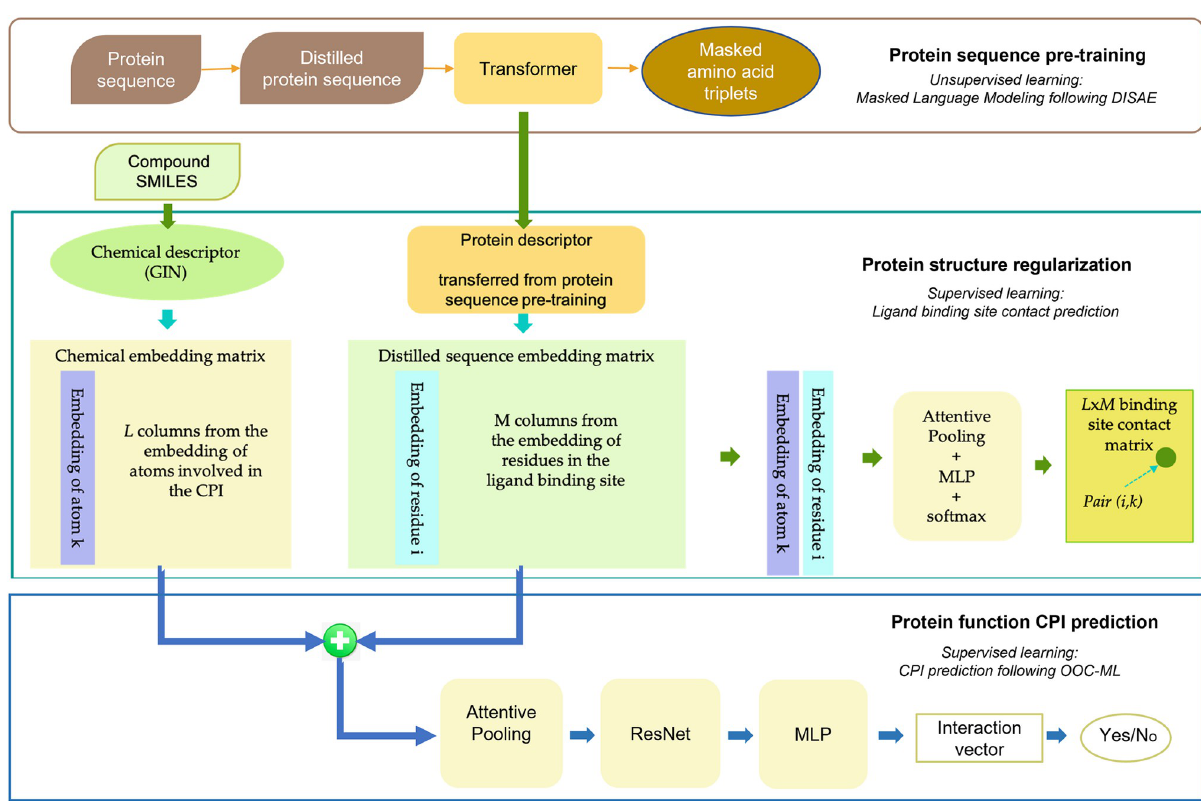
Fig 6. Illustration of PortalCG architecture in terms of its three stages of training. The architecture of protein sequence pre-training used transformer-based and masked language modeling as detailed in [1]. The pre-trained protein descriptor was then used in binding site enhanced sequence pre-training. In this stage, the task was to predict amino acid residue and ligand atom distance matrices. Finally, protein descriptors that were pre-trained and regularized in the previous two stages were concatenated with chemical descriptors via an attention network to predict CPIs. Chemical structures were represented by GIN [54], a graph neural network model (see text). The second and third stages had the same model architecture but the model parameters were transferred from the second to the third stages. OOC-ML as an optimization algorithm was not a model architecture component, and only used in the CPI